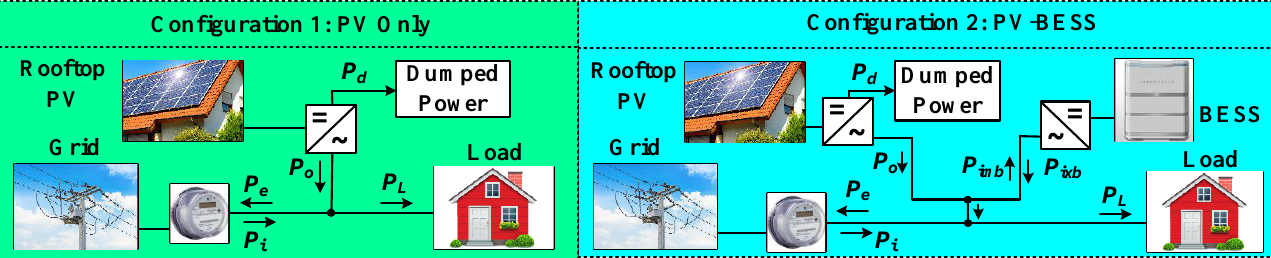
P d Figure 1. Two system configurations for a grid-connected house. 2.1. Configuration 1: PV Only